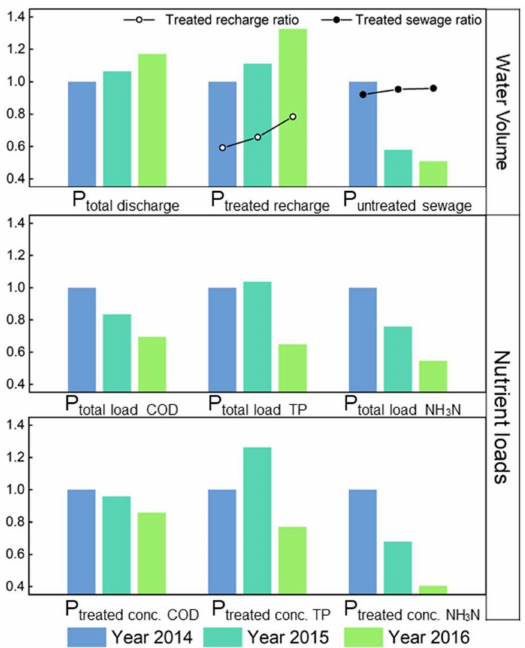
Figure 12. Ratio of discharged water volume and nutrient loads using 2014 as the base year. Treated recharge ratios (open circles) and treated sewage ratios (solid circles) are overlaid along the corresponding water volumes.